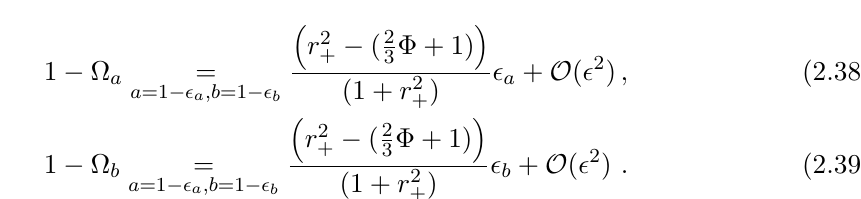
Figure 6 . The free energy for non-rotating black holes Ω = 0 . The electric potential Φ increases from right to left. There is a qualitative transition from AdS-Schwarzschild type at Φ < Φ the high potential regime Φ ≥ Φ = 3 ∗